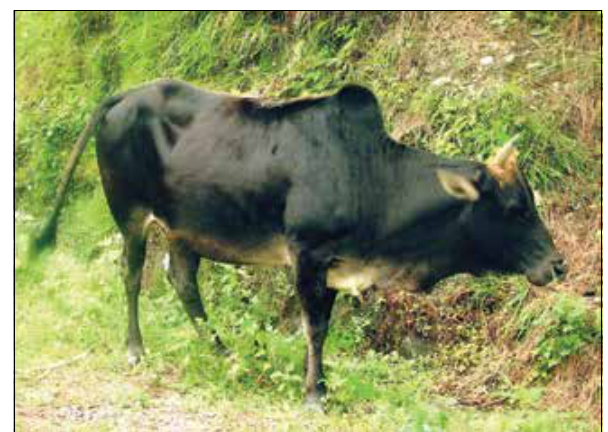
Figure-1: Adult hill cattle of Himachal Pradesh.